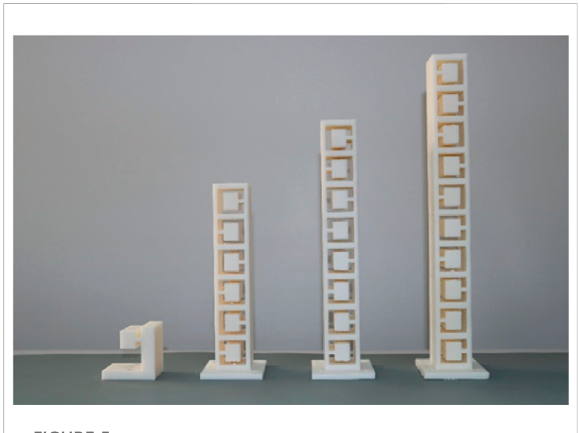
FIGURE 5 3D printed specimens (from left to right) with the